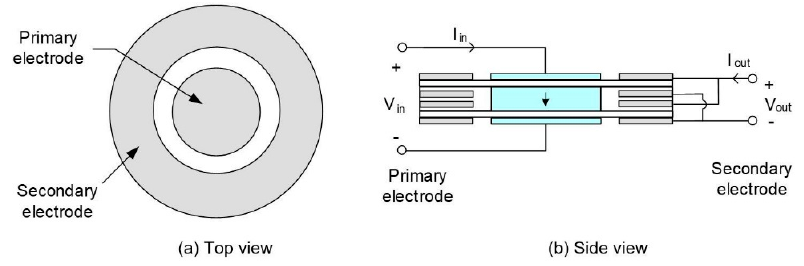
Figure 5. Structure of the radial vibration mode disk piezoelectric transformer.